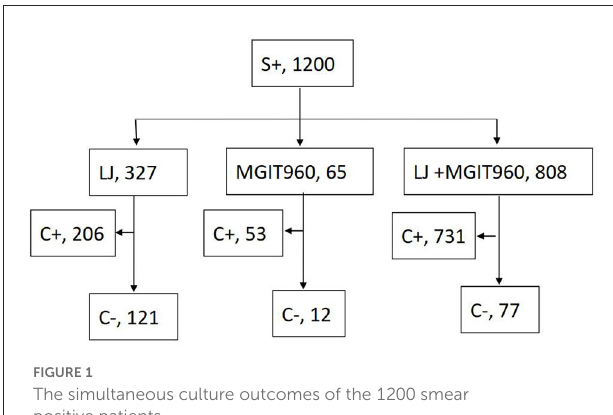
FIGURE1 The simultaneous culture outcomes of the 1200 smear positive patients.